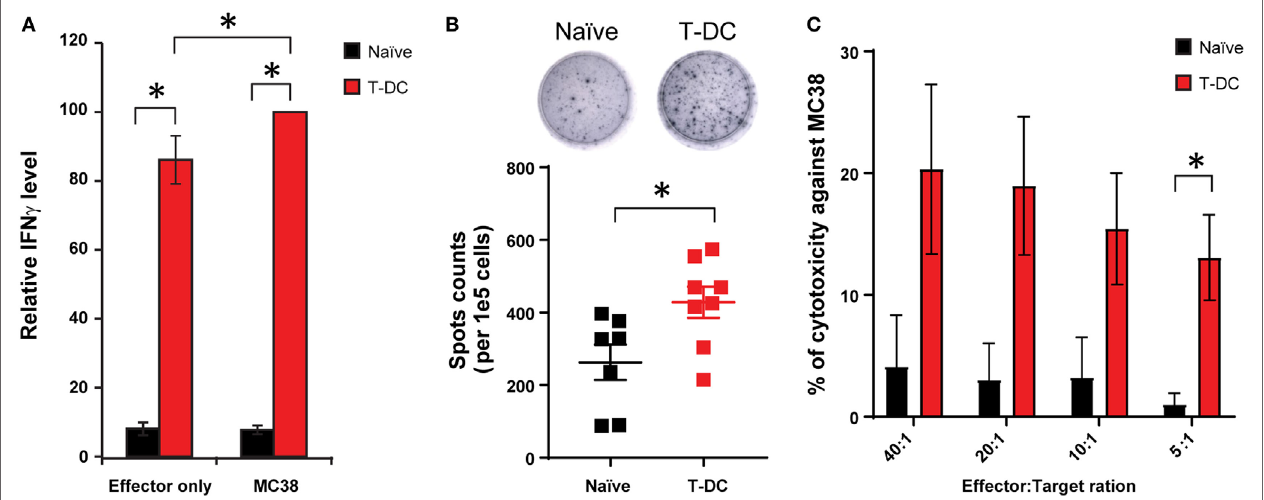
FigUre 3 | Activation of tertiary lymphoid structure (TLS)-residing lymphocytes by MC38 tumor lysate-pulsed DC (T-DC) immunization. (a) DCs were isolated from mouse bone marrow and pulsed with MC38 tumor lysate. 1e6 T-DCs were injected subcutaneously into TLS-bearing mice once a week for 3 weeks. T cells were isolated from the TLSs of mice immunized with T-DC vaccines or naïve mice, and incubated in medium alone (effector only group) or with irradiated MC38 cells (MC38 group) for 24 and 48 h. Supernatants were collected and tested for IFN γ levels using ELISA kits. IFN γ levels were normalized to the group of T-DC samples incubated with MC38 cells ( n = 19–21 for naïve group, n = 12–15 for T-DC group). (B) Detection of IFN γ secretion by purified T cells from the TLSs. Representative wells were seeded with 1.25e5 cells from indicated groups. Spots were enumerated and normalized to cell number ( n = 7 for naïve group, n = 8 for T-DC group). (c) Isolated TLS-residing T cells (effector cells) were incubated with labeled MC38 cells (target cells) at indicated ratio. Released chromium-51 was collected and measured after 5 h incubation ( n = 3 for naïve group, n = 5 for T-DC group). Data are presented as mean ± SE. * p <